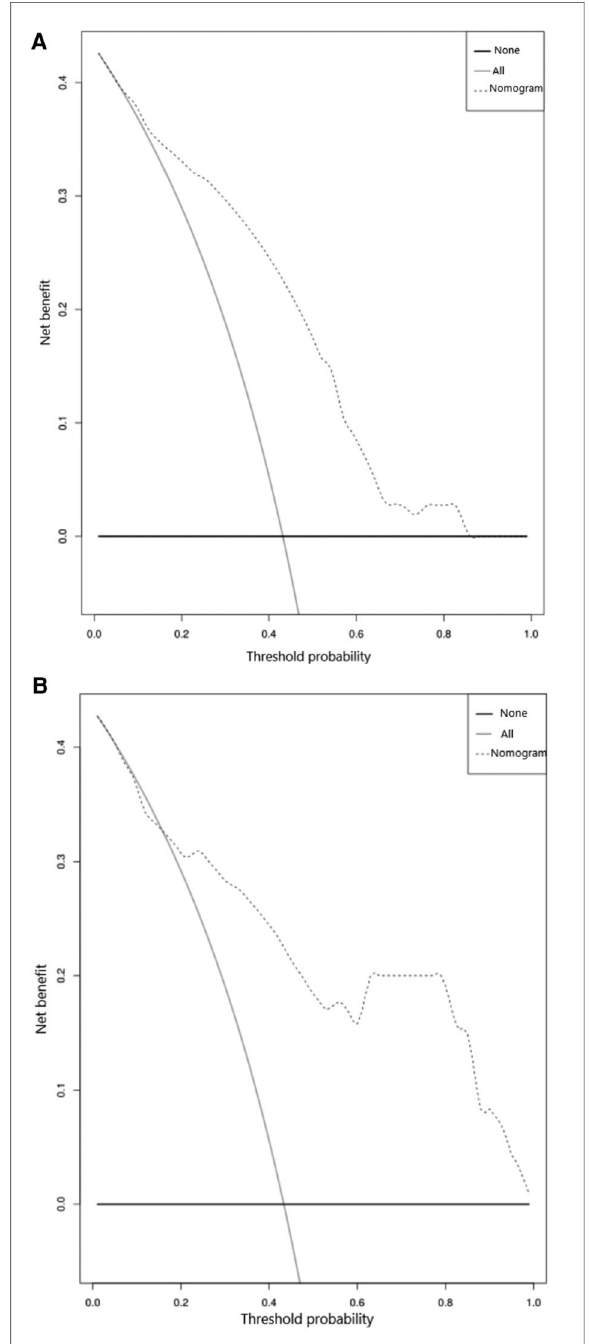
FIGURE 4 ( A ) Decision curve analysis plot of the nomogram in the training set. The dotted line indicates the clinical net bene fi ts according to the threshold probabilities, the horizontal line assumes that no cases will require the LESS-E approach, and the gray line assumes that all cases will require the LESS-E approach. ( B ) Decision curve analysis plot of the nomogram in the validation